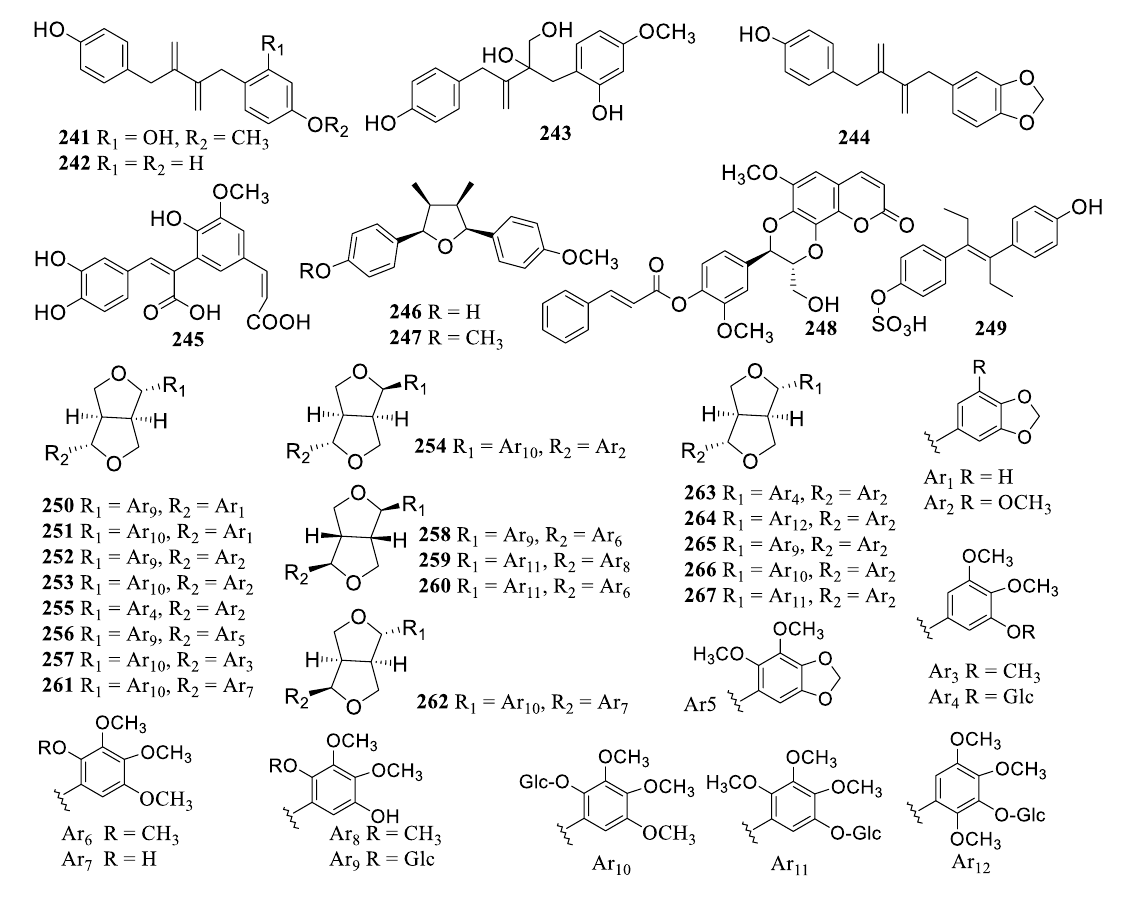
Fig. 4 The structures of lignans